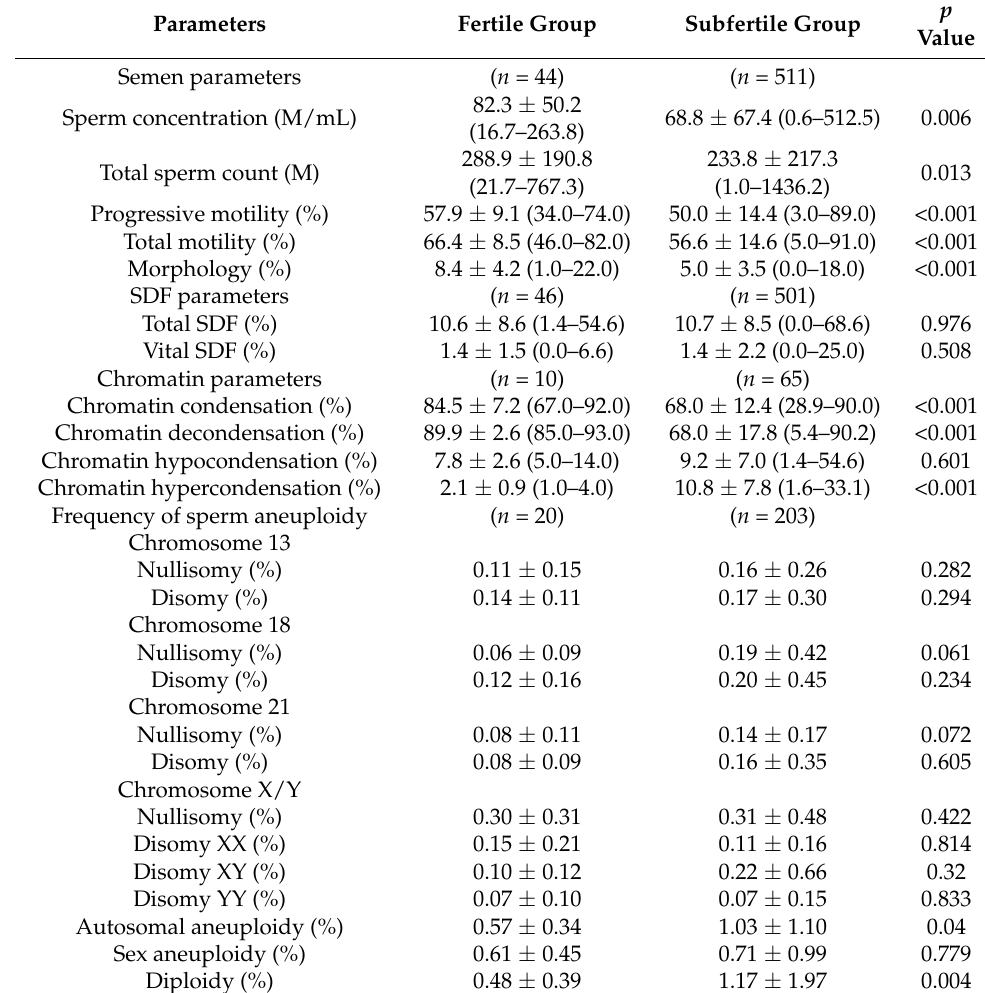
Table 5. Semen, SDF, chromatin parameters and frequency of sperm aneuploidy in the fertile and subfertile